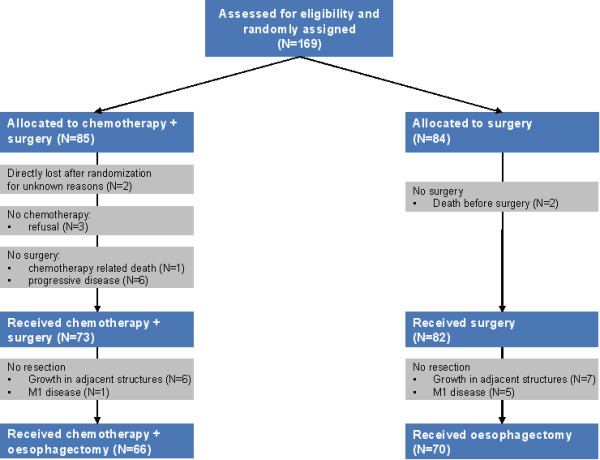
CONSORT Flow-diagram: random assignment, and compliance to the allocated treatment. CTX, chemotherapy